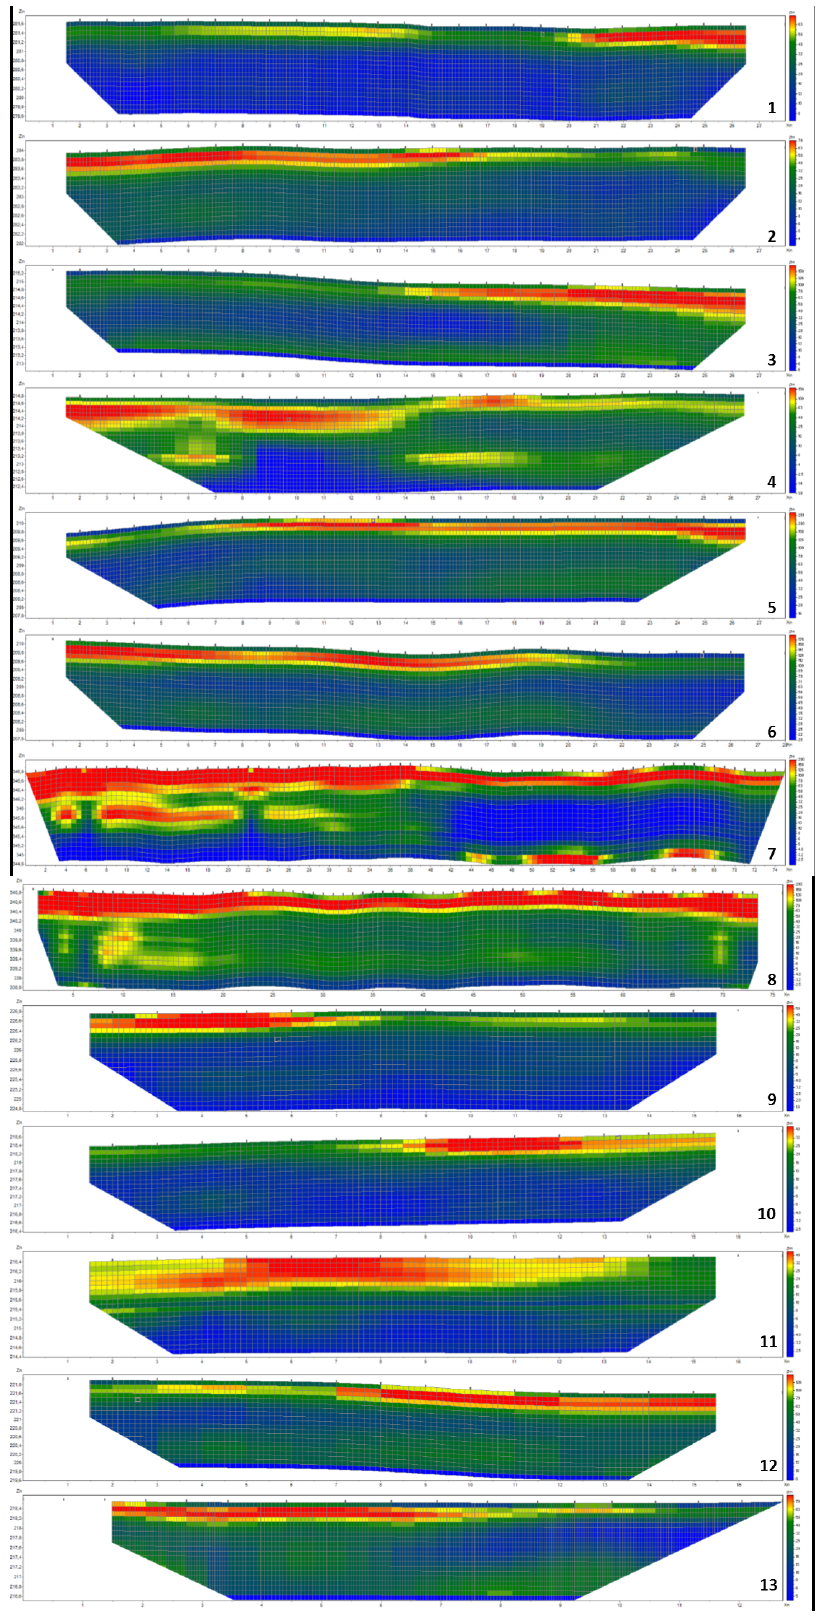
Figure 5: Electrical Resistivity